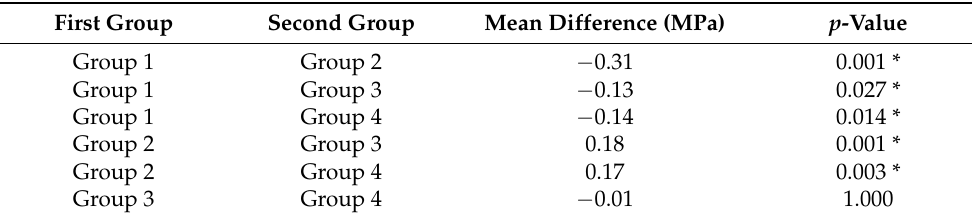
Table 7. Inter-group comparison of the mean values of the tensile strengths using the post hoc Bonferroni test.